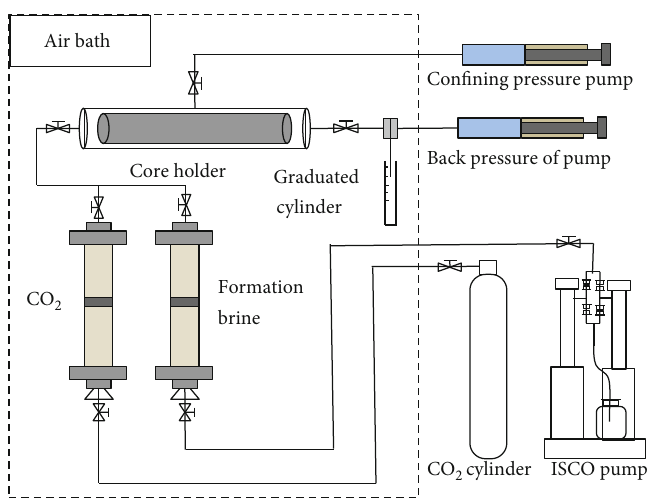
Figure 2: Schematic diagram of the core- fl ood apparatus.